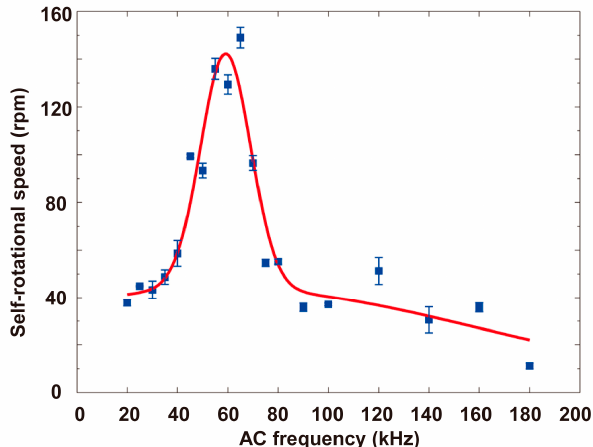
Figure 14. Self-rotational speeds of a Raji cell with different applied AC frequencies. The applied AC bias potential is 10 V pp . The measurement points in this figure were obtained for only one Raji cell. At each measurement point, the cell continually rotated for several cycles, and the numbers of rotation cycles are {4, 4, 5, 8, 4, 5, 6, 5, 5, 3, 9, 9, 5, 5, 3, 5, 2, 3, 2} respectively. In the figure, each data point represents a mean value ± maximum deviation. The Raji cell is the same cell observed in the above experiment.